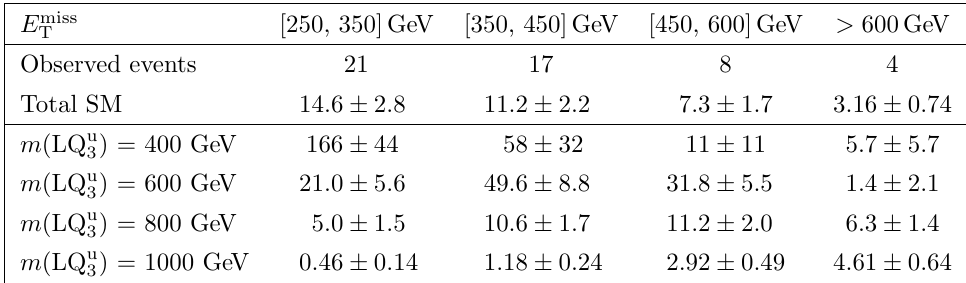
Table 4 . The number of observed events in the shape-(cid:12)t SR tN med, together with the expected number of background events including their total uncertainties, taken from ref. [22]. Additionally, the expected number of signal events are given for B = 0 for up-type LQs of di(cid:11)erent masses with statistical uncertainties. The numbers are given for the four bins characterized by an interval of